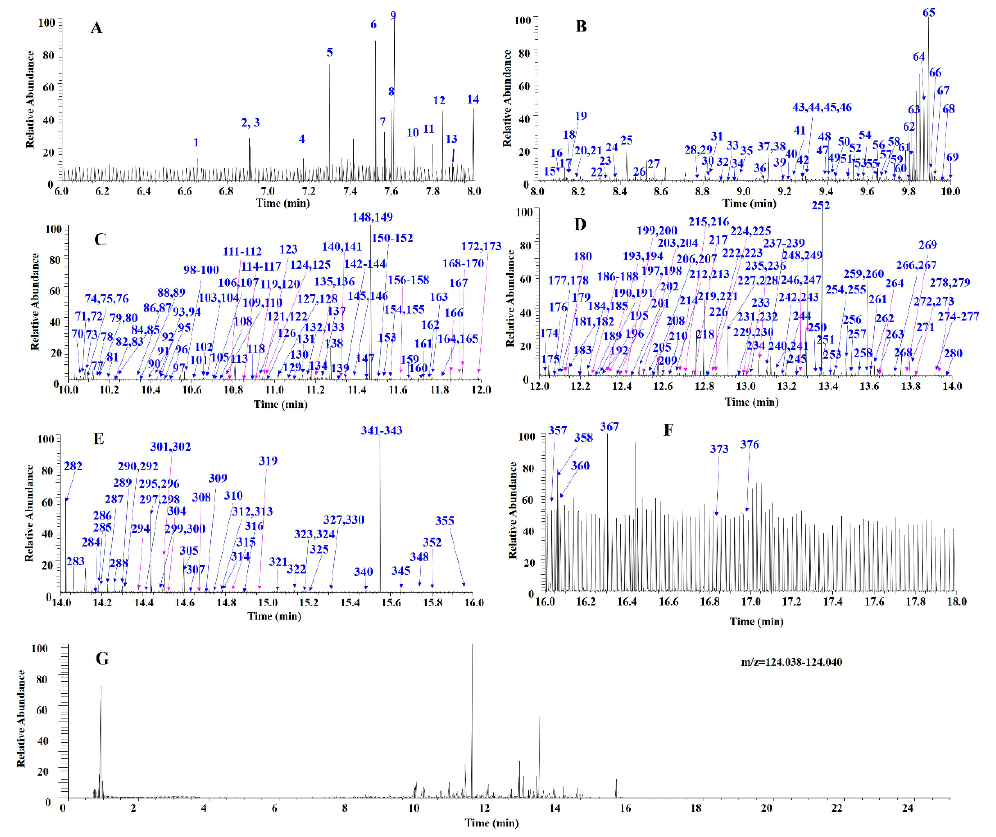
Figure 4. The stepwise DPIs filtering chromatograms of m / z 124.0393 ( G ) with six time-windows set as follows: ( A ) 6.0–8.0 min; ( B ) 8.0–10.0 min; ( C ) 10.0–12.0 min; ( D ) 12.0–14.0 min; ( E ) 14.0–16.0 min; ( F ) 16.0–18.0 min.